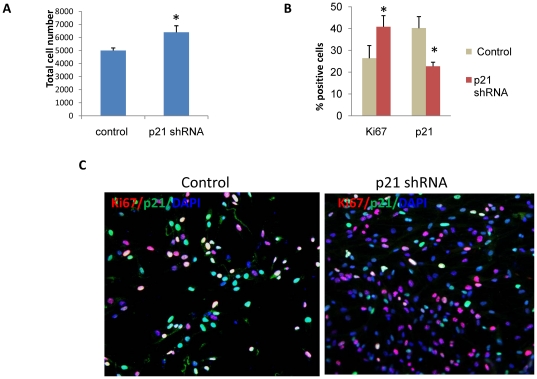
Conditional suppression of p21 enhances proliferation of WT NPC.
A) One thousand WT NPC cells were kept in proliferating conditions for 4 days. Cells were cultured in 24-well plates in triplicates. The mean number of cells at the time of collection; B) Cells were fixed and stained for Ki67 or p21 . The graph depicts the percentage of p21- or Ki67-positive cells in each culture. Counting was performed in triplicates (>500 cells per sample). Data are presented as a mean ± SEM, *, p<0.05. Two independent experiments were conducted, and representative results are shown; C) Representative confocal images of NPC treated with either control lentivirus (control) or lentivirus expressing p21 shRNA. The cells were stained for Ki67 (intranucelar, red) and p21 (intranuclear, green). Note the increased number of Ki67-positive and the decreased number of p21-positive cells after p21 shRNa treatment.